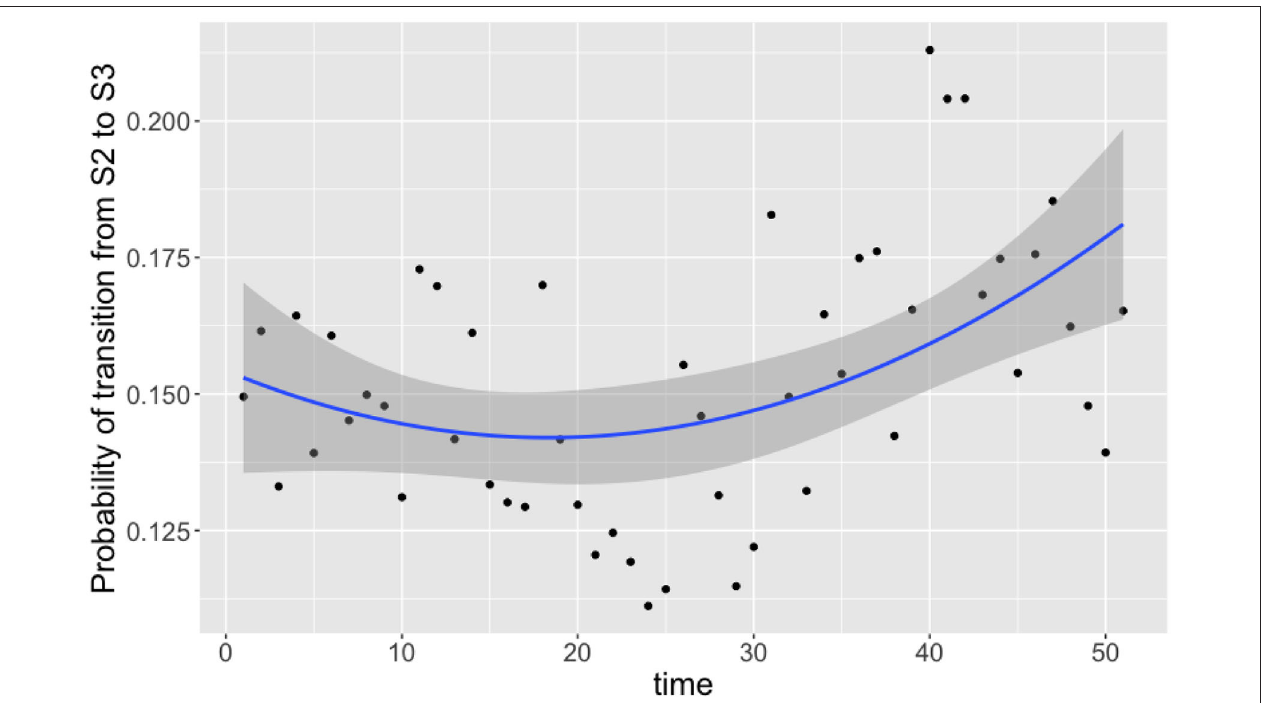
FIGURE 7 | Transition probabilities between state 2 “colonized by C. jejuni ” and state 3 “colonized by C. coli ” against time. Each point is the calculated transition probability for that time point. Also plotted is a quadratic regression against these points in blue, with a shaded region depicting the 95% confidence interval. The transition probability was found to be statistically significant for correlation against time ( t -test, p <